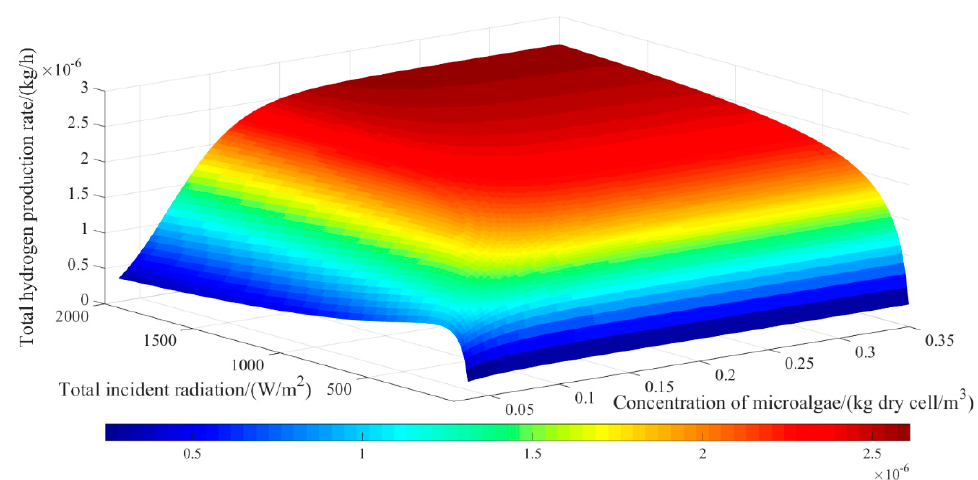
Figure 12. The surface of hydrogen production of fitting.